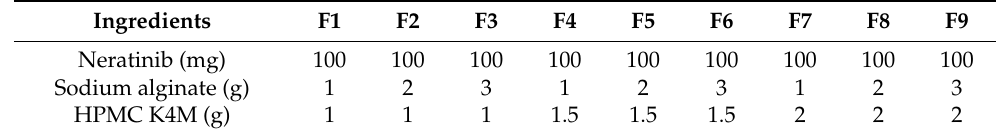
Table 1. 3 2 factorial design for the oral raft-forming in situ gelling system of neratinib, an anticancer drug, obtained using Design-Expert software (version 130.2.0) from Stat-Ease Inc., Minneapolis, MN,